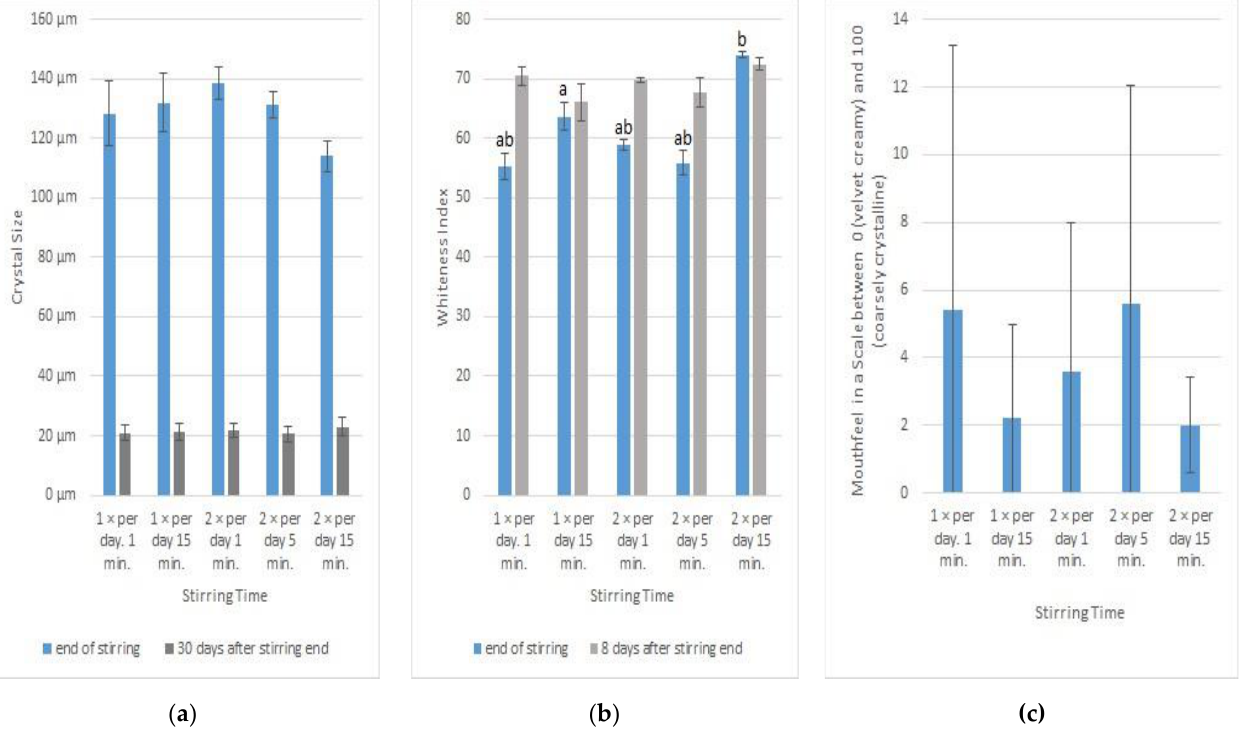
Figure 5. Influence of the stirring time on the creaminess of honey. (a, b denote groups of signifi- cantly different samples.) ( a ): Mean and standard deviation of the size of the 10 largest crystals on different days. ( b ): Mean and standard deviation of whiteness index of the honey on different days. ( c ): Mouthfeel of the honey, tested 20 days after stirring end by five trained sensory testers on a scale between 0 (velvet creamy) and 100 (coarsely crystalline; average scale and standard deviation).